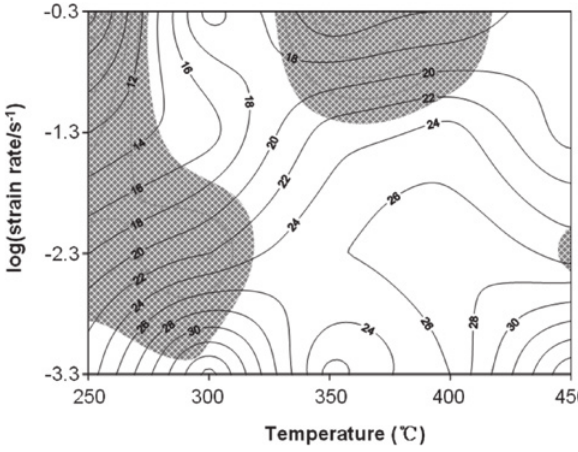
Fig. 6: Processing map of 7005 alloy corresponding to a strain of 0.7.